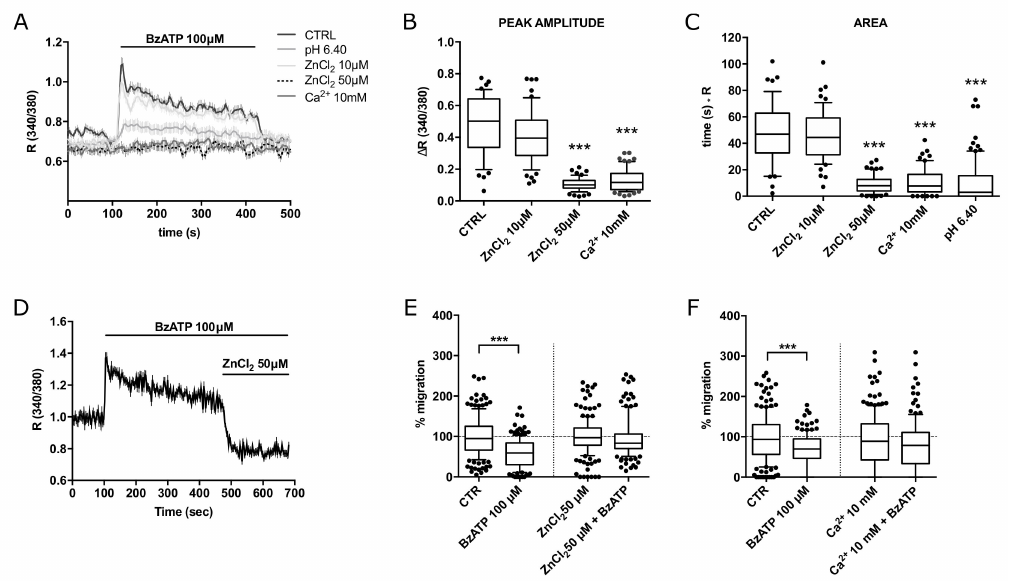
Figure 5. BzATP-dependent calcium signals in BTEC are sensitive to extracellular zinc and high